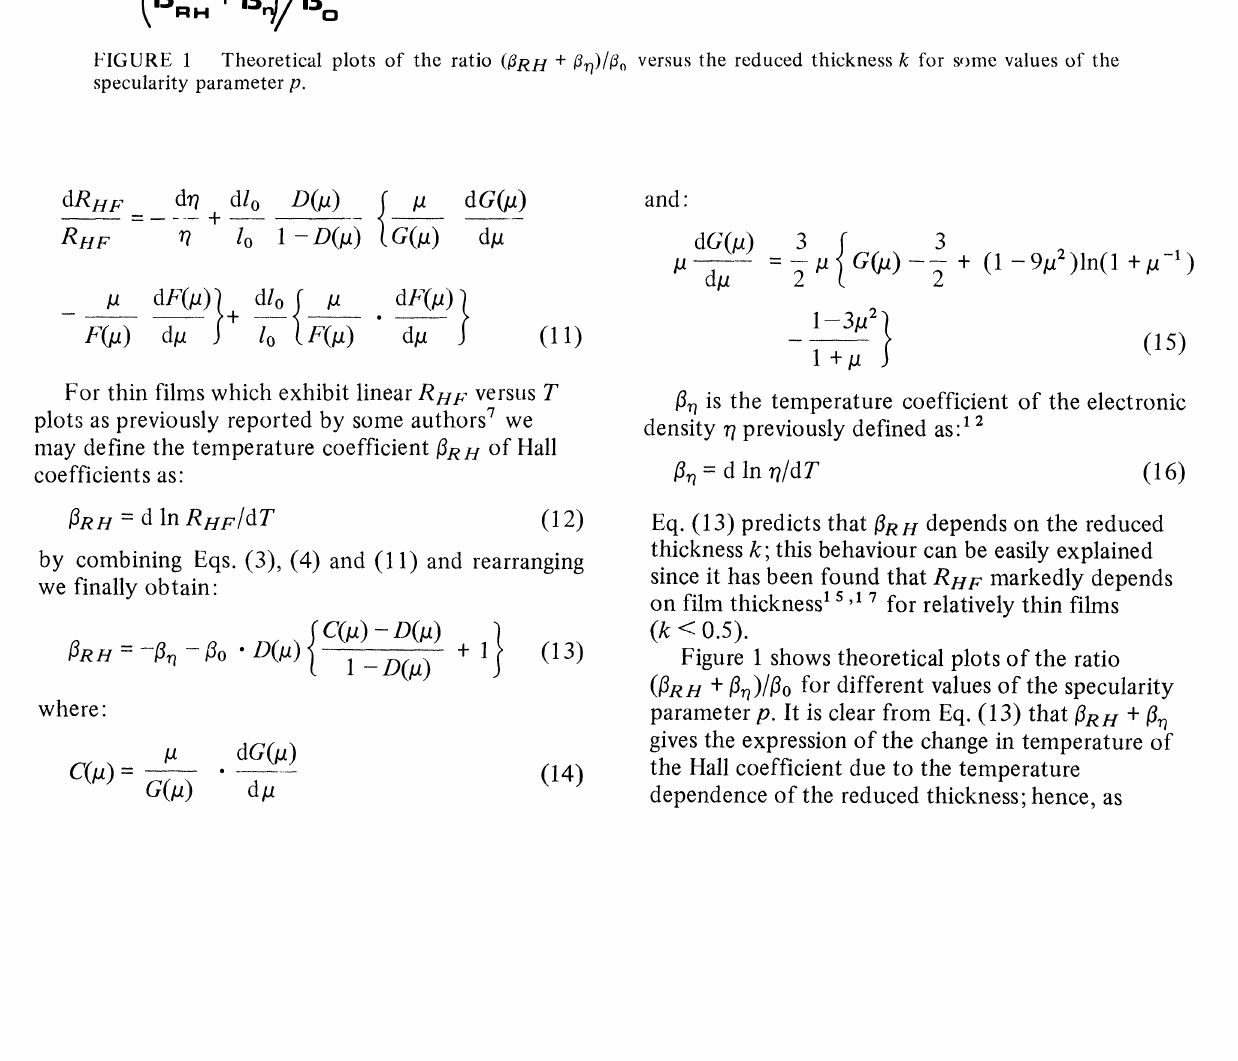
FIGURE Theoretical plots of the ratio (3RH + 3r)/3o versus the reduced thickness k for some values of the specularity parameter